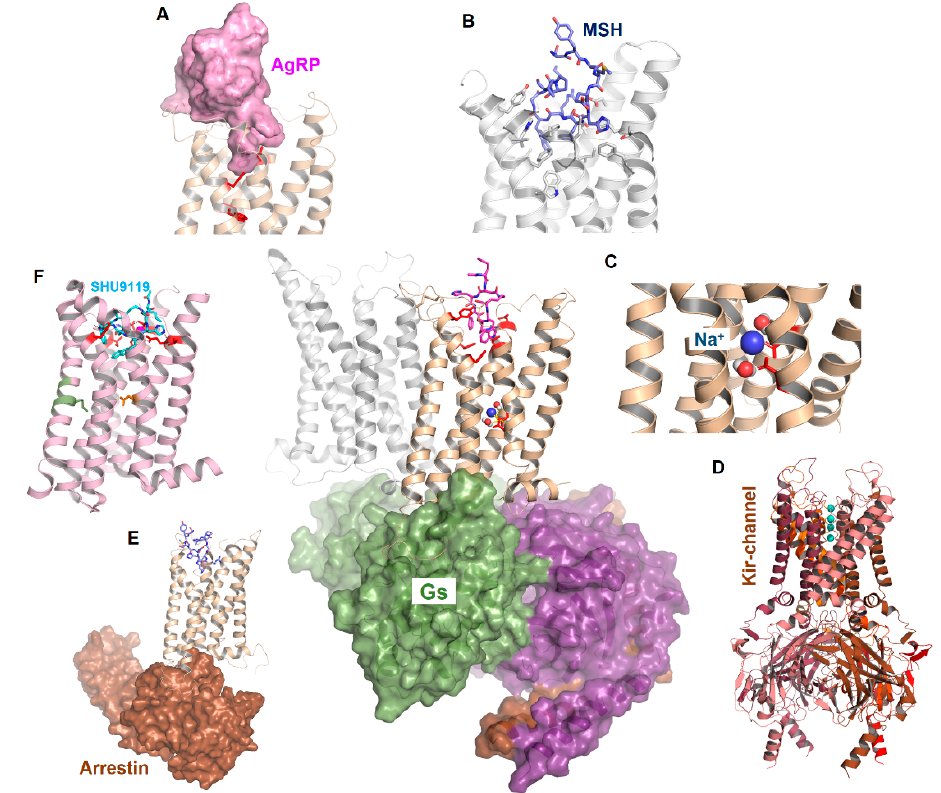
Figure 1. Scheme of MC4R interrelations. The figure reflects functional-structural aspects related to MC4R signal transduction. Middle: Potential interaction of an MC4R dimer with a heterotrimeric G protein (surface representation). ( A ) represents the binding of AgRP, ( B ) the binding of α -MSH, and ( C ) the potential binding of sodium. ( D ) indicates an association with other proteins such as Kir channels and ( E ) arrestin binding with the MC4R. ( F ) The recently described crystal structure of the MC4R in the inactive state is bound to a peptide antagonist (SHU9119).